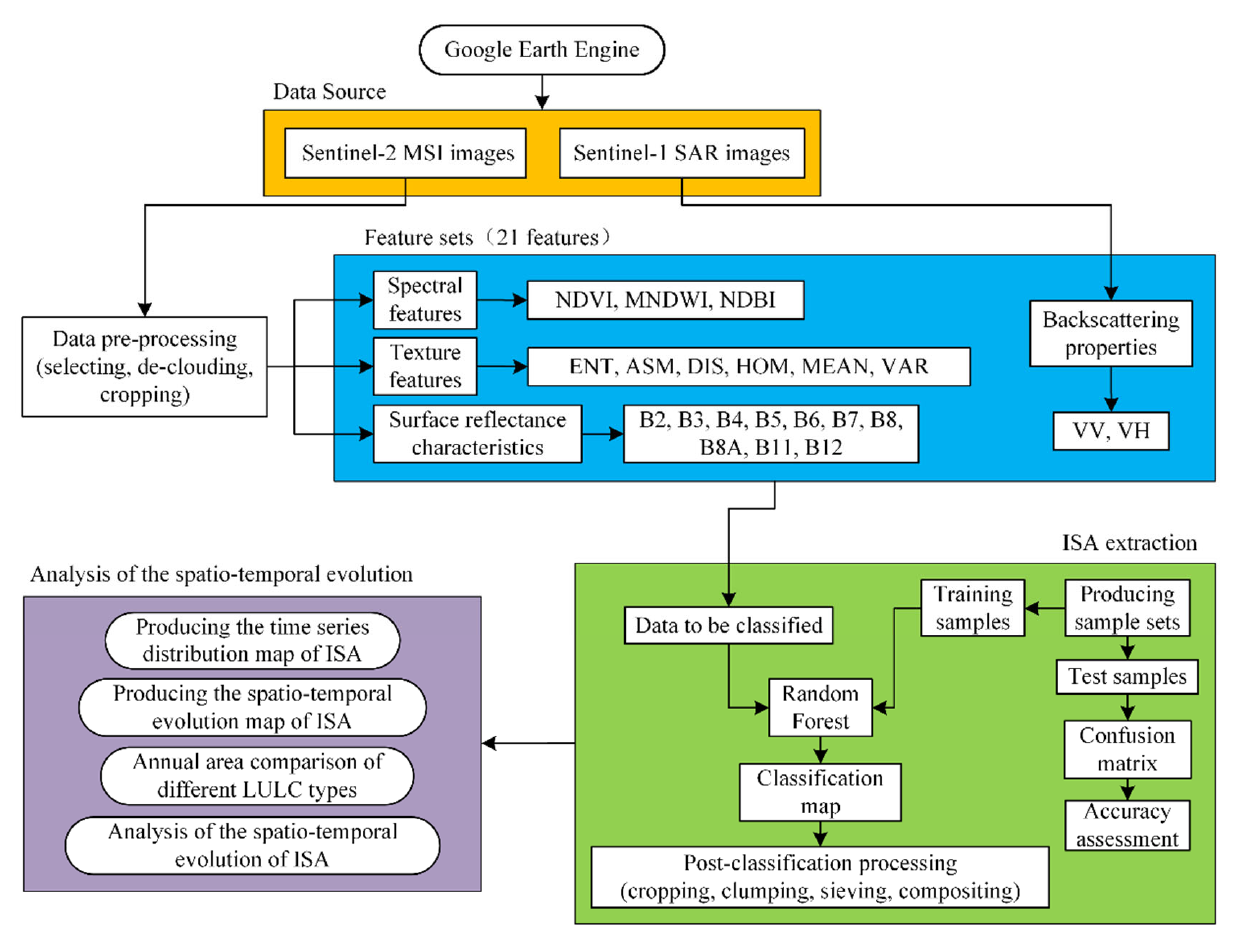
Figure 2. Methodology flowchart.